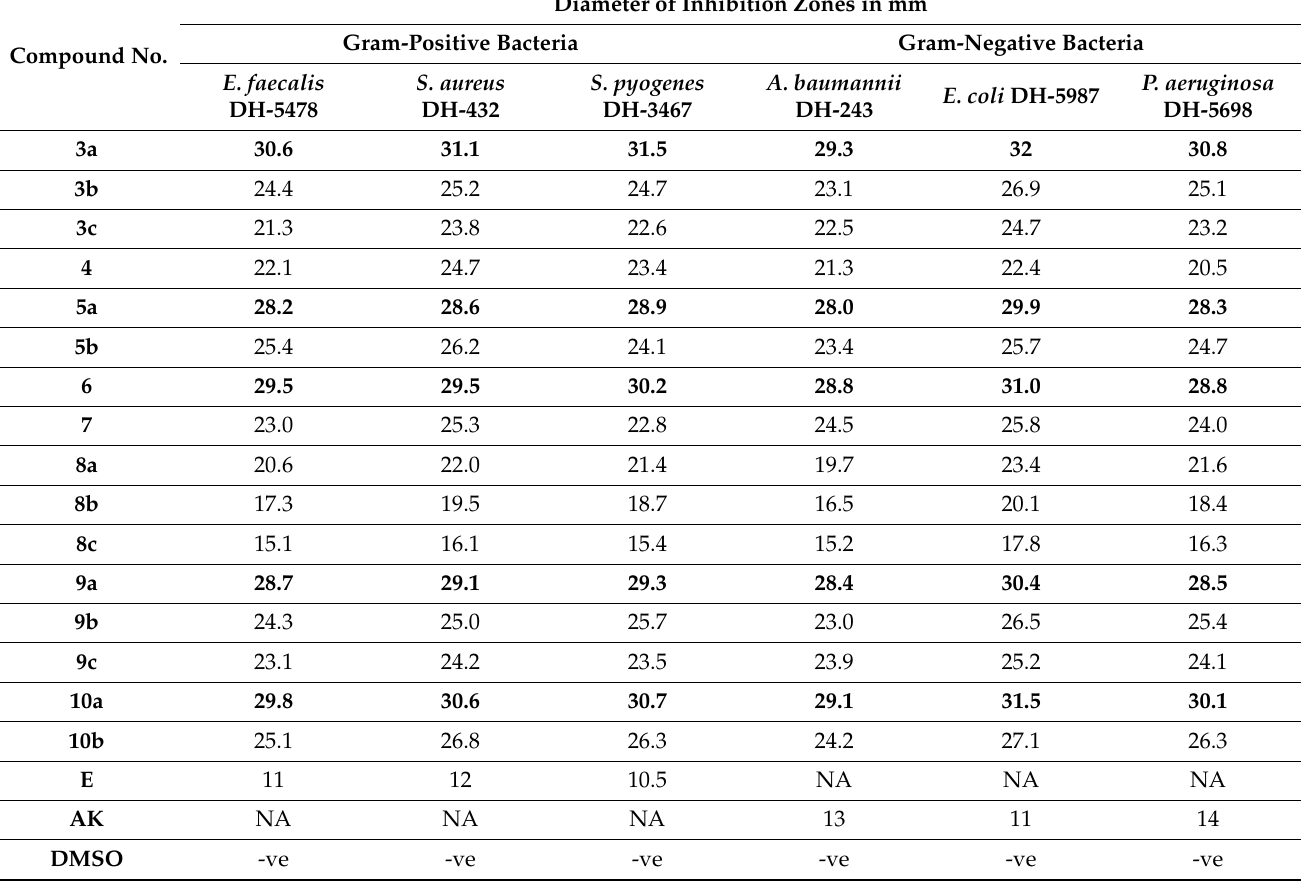
Table 1. Average zones of inhibition (AZOIs) of novel pyrazole, pyrazolo[1,5- a ]pyrimidine derivatives, and control antibiotics against clinical pathogenic bacteria recorded in